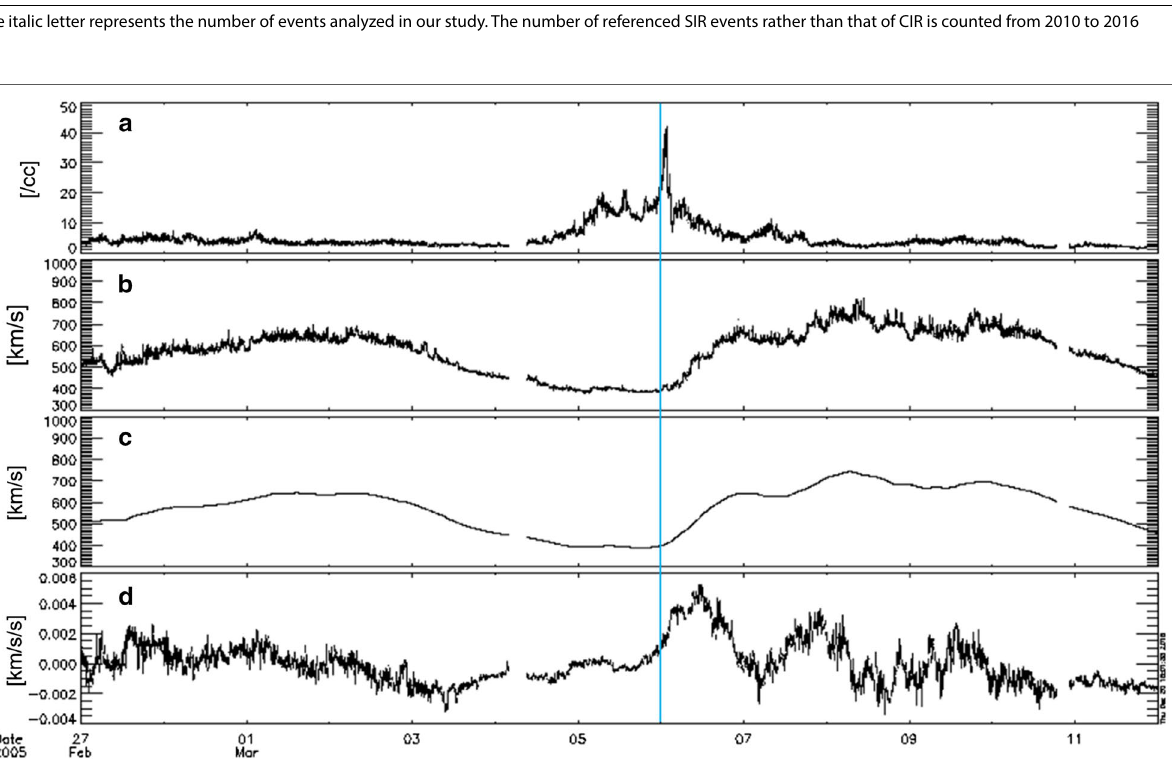
The italic letter represents the number of events analyzed in our study. The number of referenced SIR events rather than that of CIR is counted from 2010 to 2016